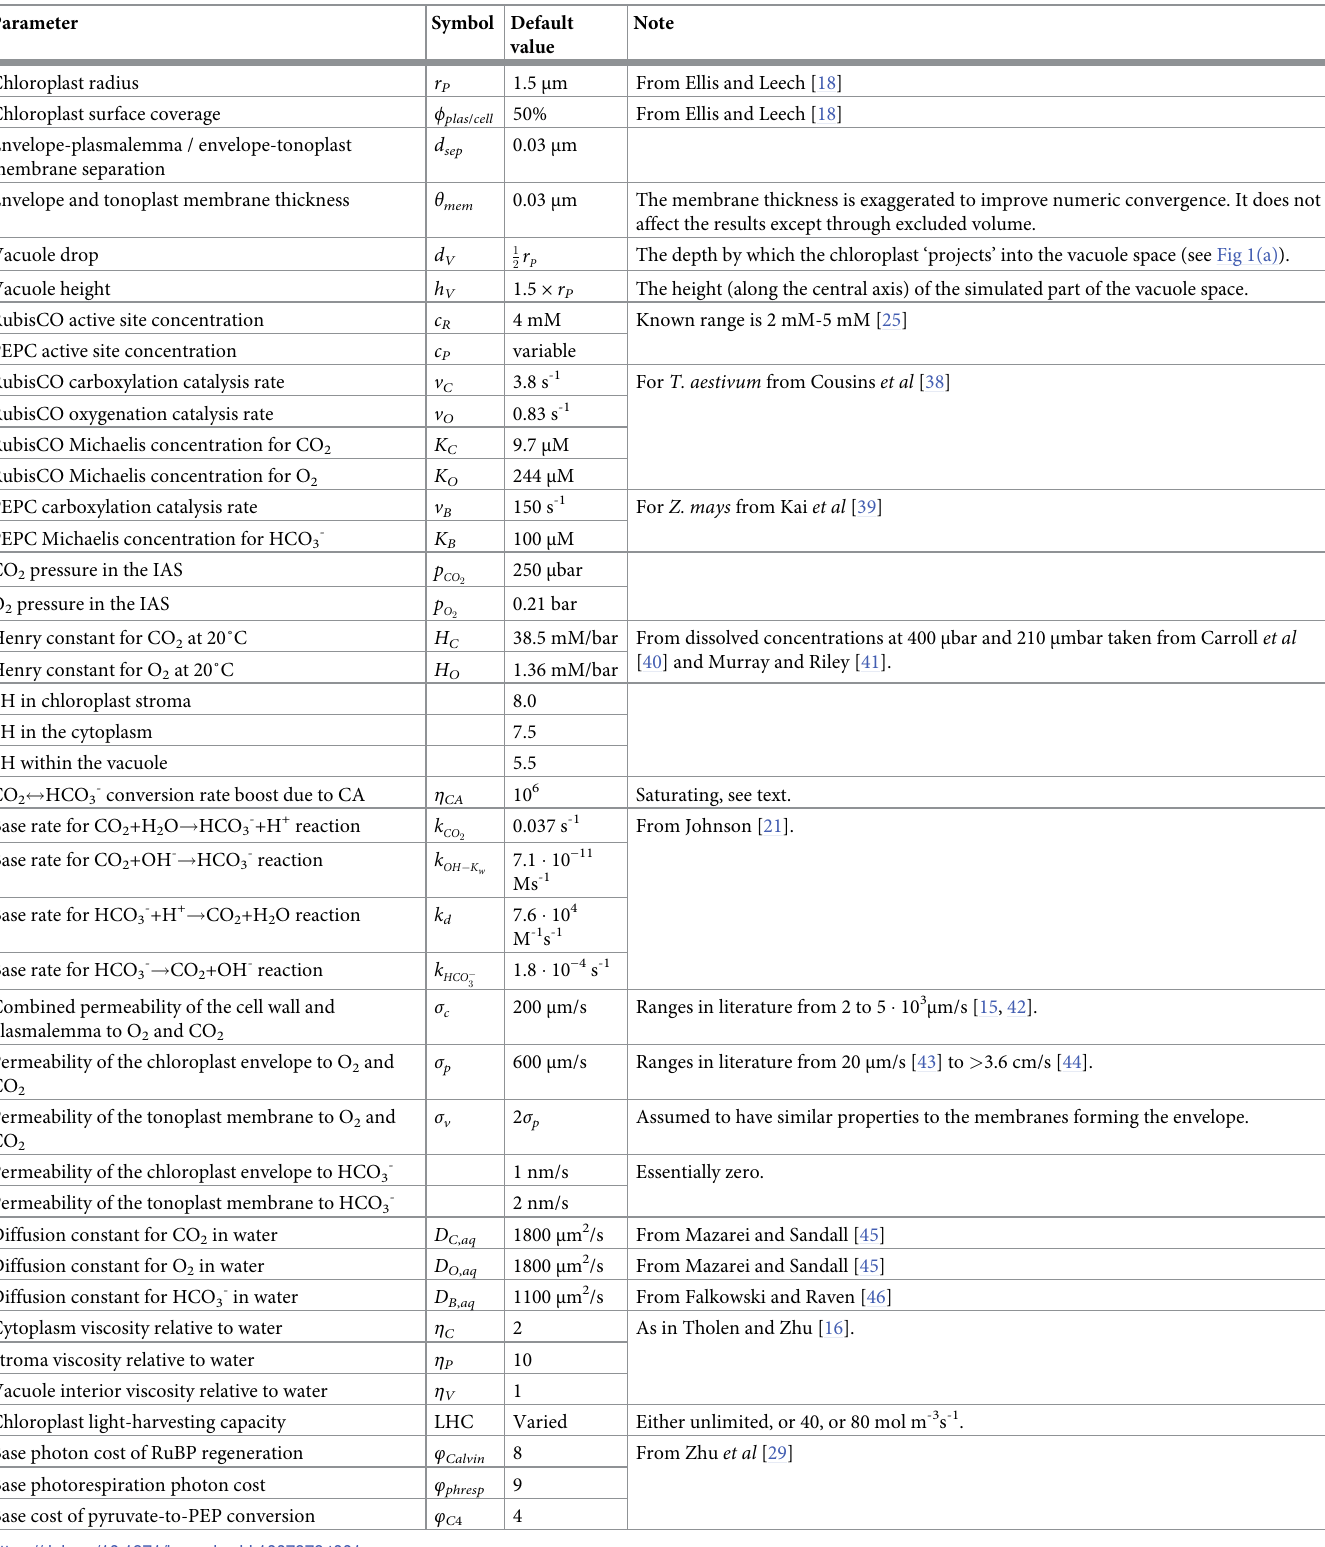
Table 1. The list of parameters used in the model and in calculation of derived measures. Where not explicitly varied, the parameters are fixed at their default